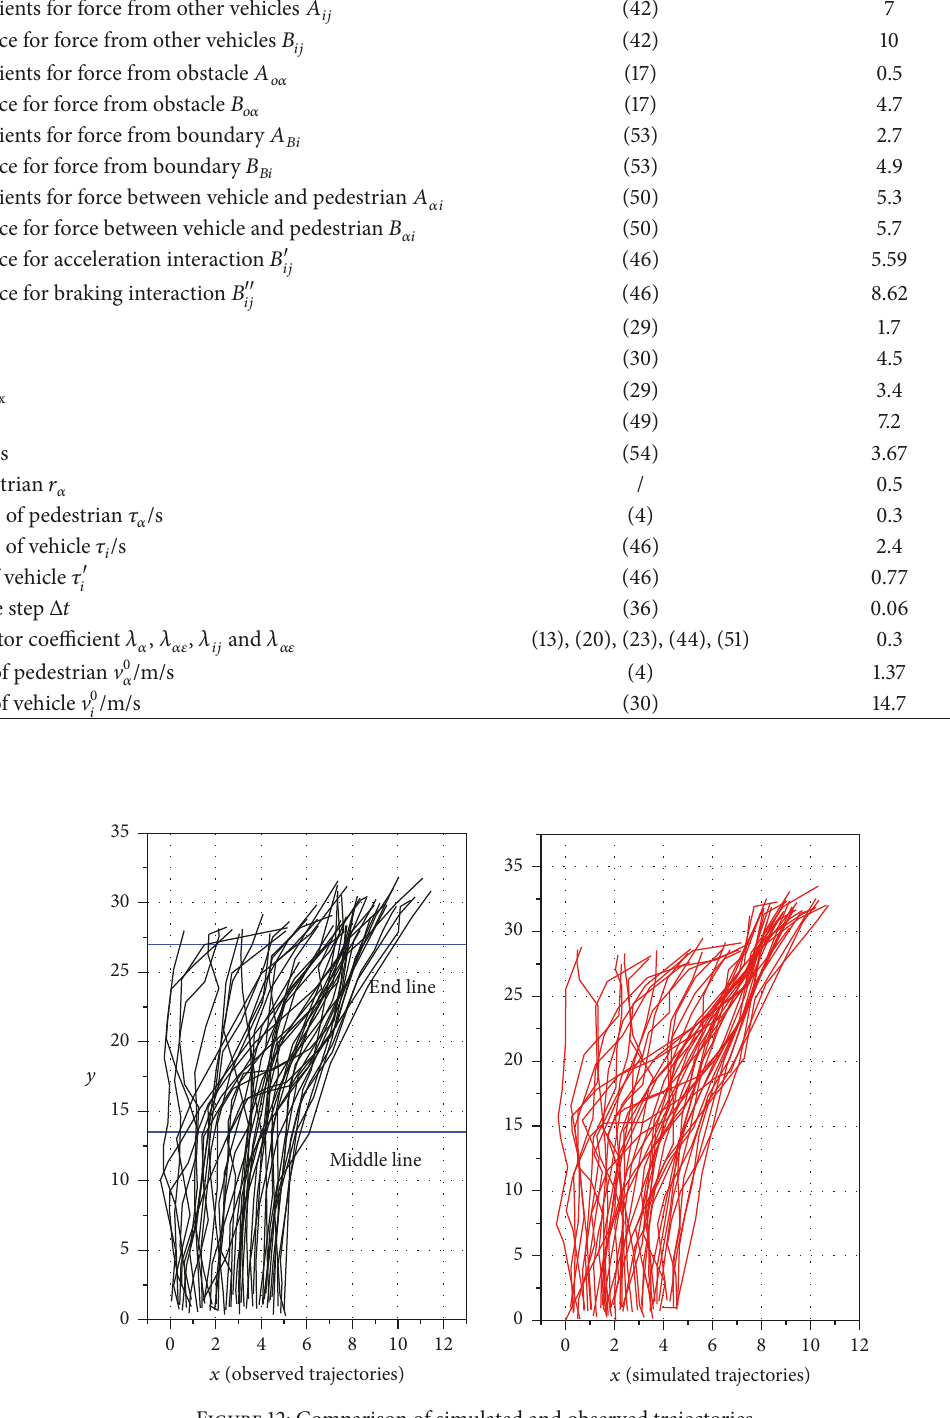
Figure 12: Comparison of simulated and observed